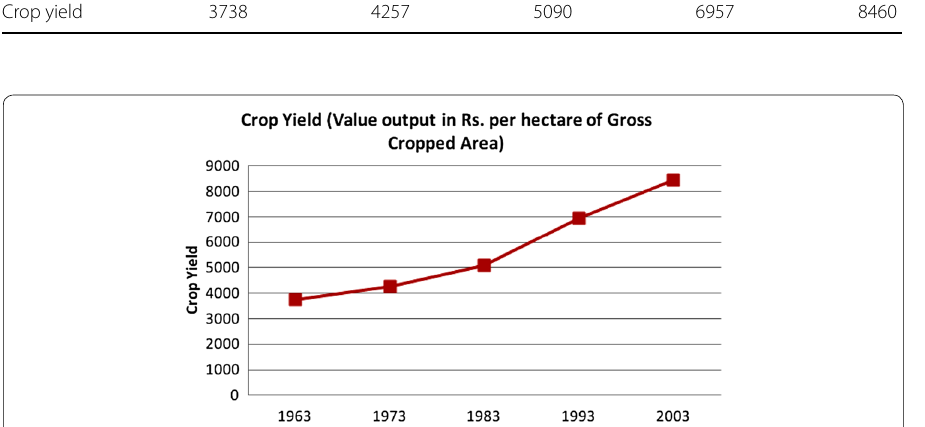
Fig. 2 Crop yield in India. Graph shows the value output of crops per hectare of gross cropped area in